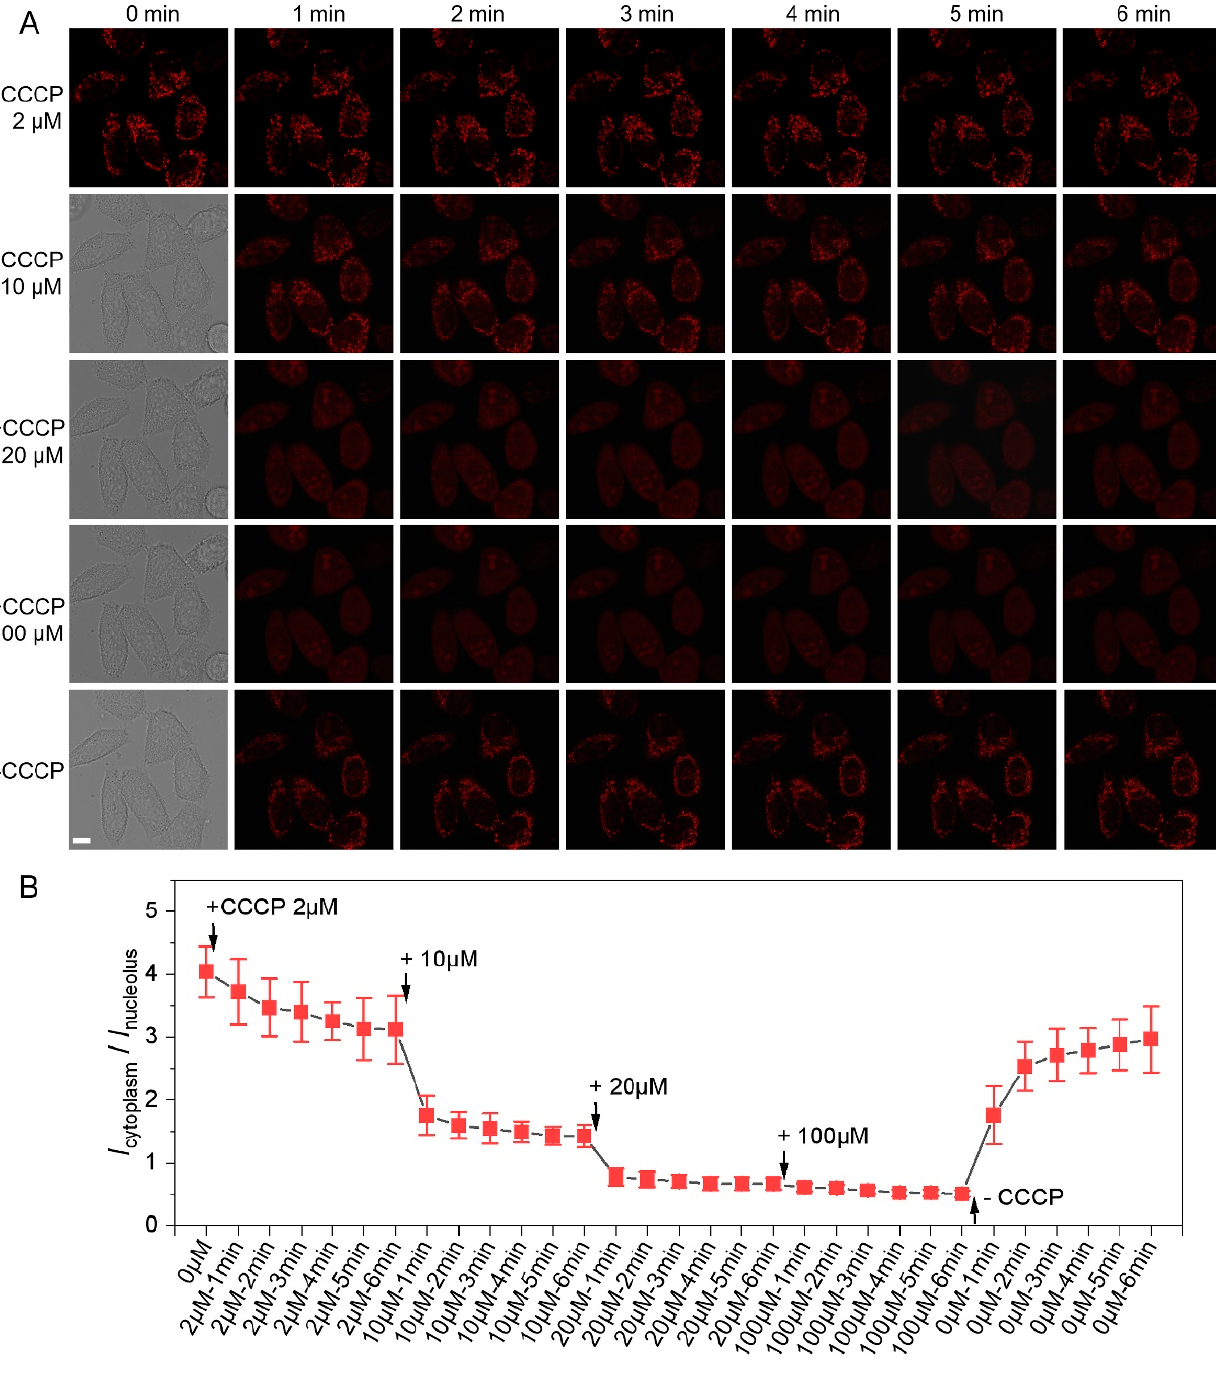
Figure 4. Dynamic MMP monitoring. ( A ) CLSM imaging of live HeLa cells stained with 10 µM PQ when incubated continuously in 2–100 µM CCCP for 0–6 min ( λ ex / λ em = 488 nm/550–650 nm, scale bar: 10 µm) and ( B ) Corresponding I cytoplasm / I nucleolus changes, data represent mean ± SD (n = 5).